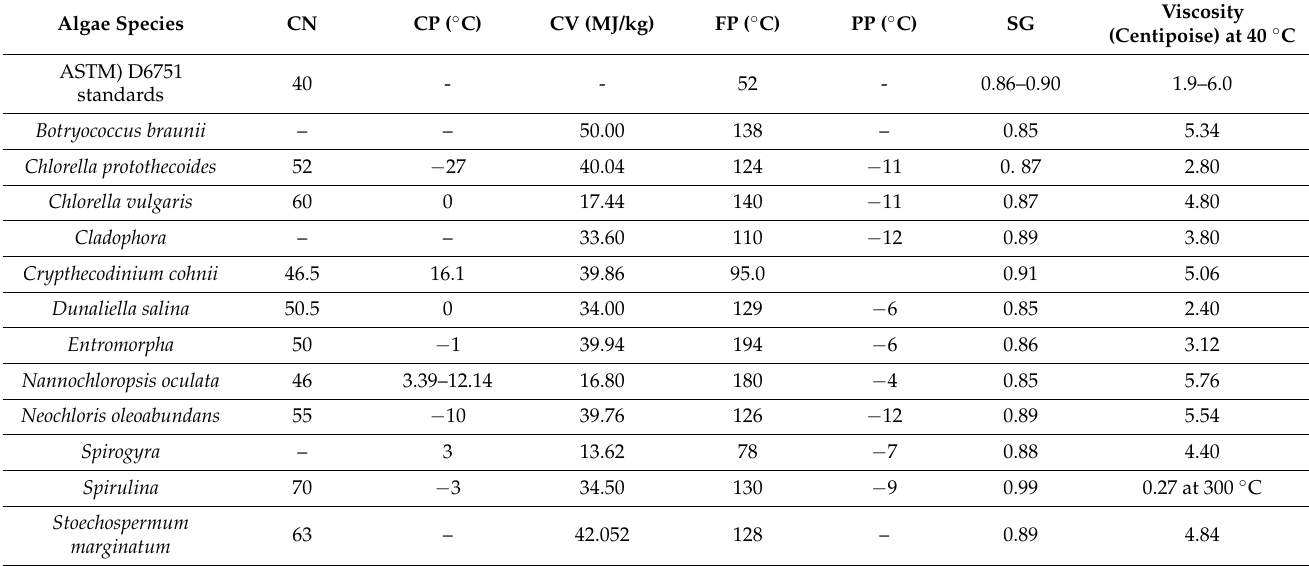
Table 4. Physicochemical properties of microalgal biodiesel. Reproduced from [98], Elsevier B.V.: 2021. Algae Species